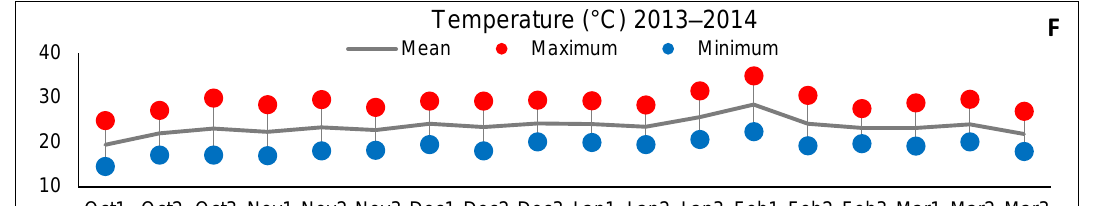
Figure 2. Water balance (WB) calculated according to Thornthwaite and Mather [15] and mean temperature (T°) for 10-day periods (1, 2, 3) over three crop seasons in Londrina, PR, Brazil. ( A ). WB 2010/2011; ( B ). T° 2010/2011; ( C ). WB 2011/2012; ( D ). T° 2011/2012; ( E ). WB.2013/2014; ( F ). T° 2013/2014.